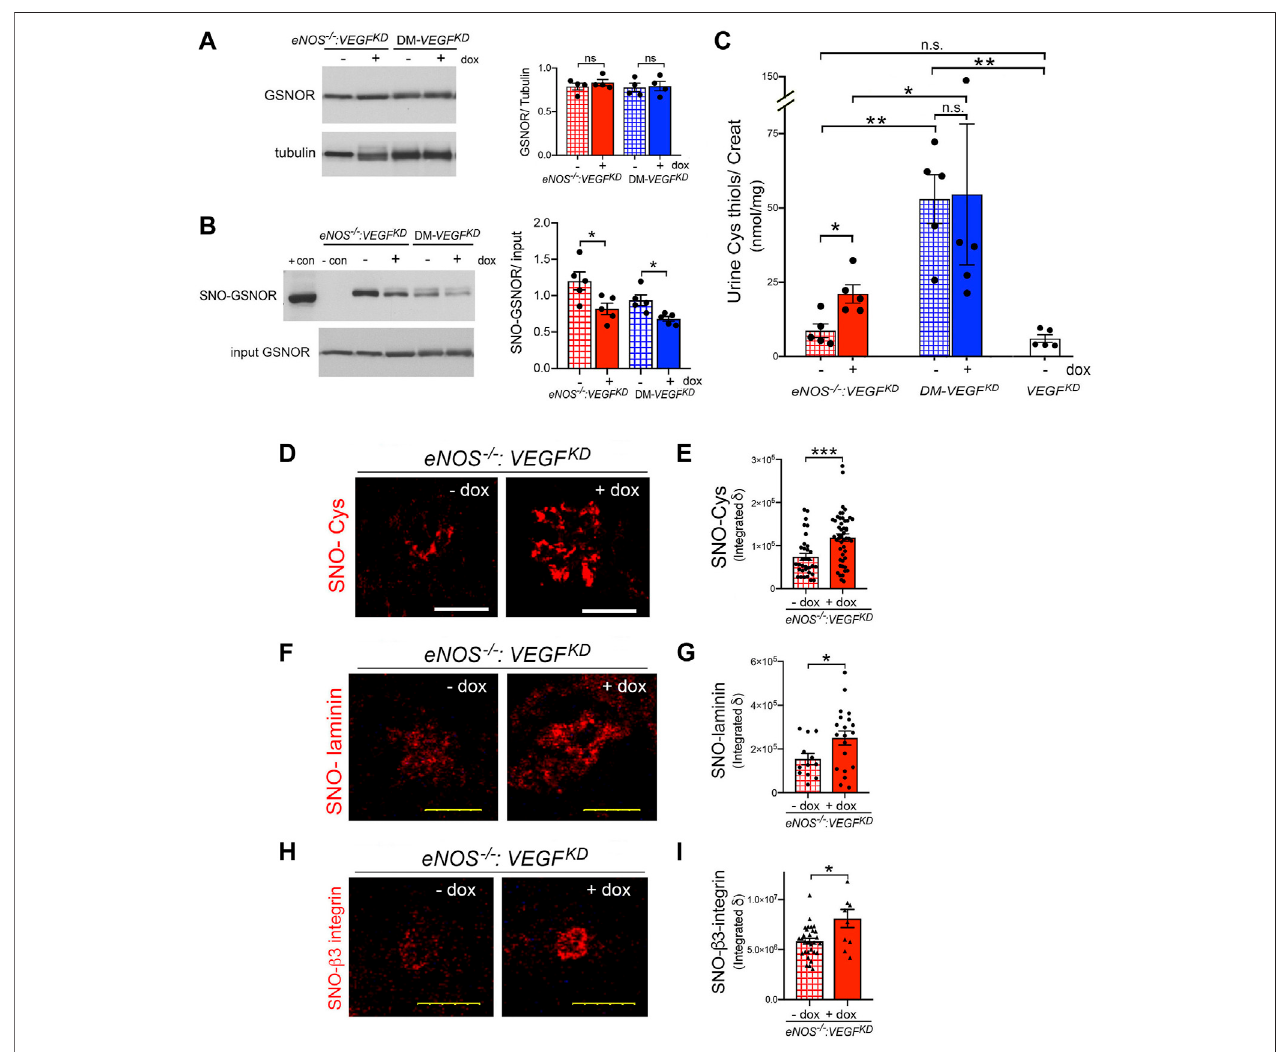
FIGURE 7 | Podocyte VEGF KD induces thiol-mediated mechanisms in diabetic and eNOS − / − :VEGF KD mice. (A) WB: Kidney GSNOR expression is not altered by diabetes or VEGF KD , tubulin is shown as loading control. (B) GSNOR S-nitrosylation (SNO-GSNOR) detected by BST: VEGF KD (+dox) decreases SNO-GSNOR in eNOS − / − :VEGF KD and diabetic kidneys; podocyte and kidney lysates are used as SNO positive and negative BST controls, respectively, input shows equal loading for BST. (C) UrineCysthiolexcretion(normalizedtocreatinine):podocyte VEGF KD increases ~2.5 fold Cys thiol excretion in eNOS − / − :VEGF KD + dox mice (red bar) (*, p = 0.013); diabeticmice(bluebars),irrespectiveof VEGF KD ,have~6-foldhigherCysthiolexcretion thanuninducednon-diabeticmicewithintact eNOS ( VEGF KD − dox, white bar) (**, p = 0.004) or eNOS − / − :VEGF KD − dox (hatched red bar) (**, p = 0.004). (D) IHC: podocyte VEGF KD (+ dox) increases S-nitrosylation of glomerular proteins in eNOS − / − :VEGF KD kidneys,SNO-Cysquanti fi cationisshownin (E) ,(****, p =0.0003). (F) PLA:showsthatpodocyte VEGF KD (+dox)increaseslamininS-nitrosylation(SNO-laminin) in eNOS − / − :VEGF KD kidneys, SNO-laminin PLA quanti fi cation is shown in (G) (*, p = 0.025). (H) PLA: shows β 3-integrin S-nitrosylation (SNO- β 3-integrin) in eNOS − / − :VEGF KD glomeruli, which is increased by podocyte VEGF KD (+dox); SNO- β 3-integrin quanti fi cation is shown in (I) (*, p = 0.036).